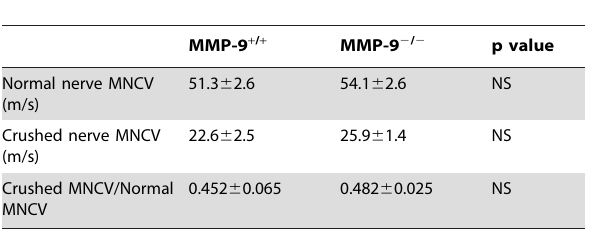
Table 3. MNCV in MMP-9 2 / 2 and MMP-9 + / +